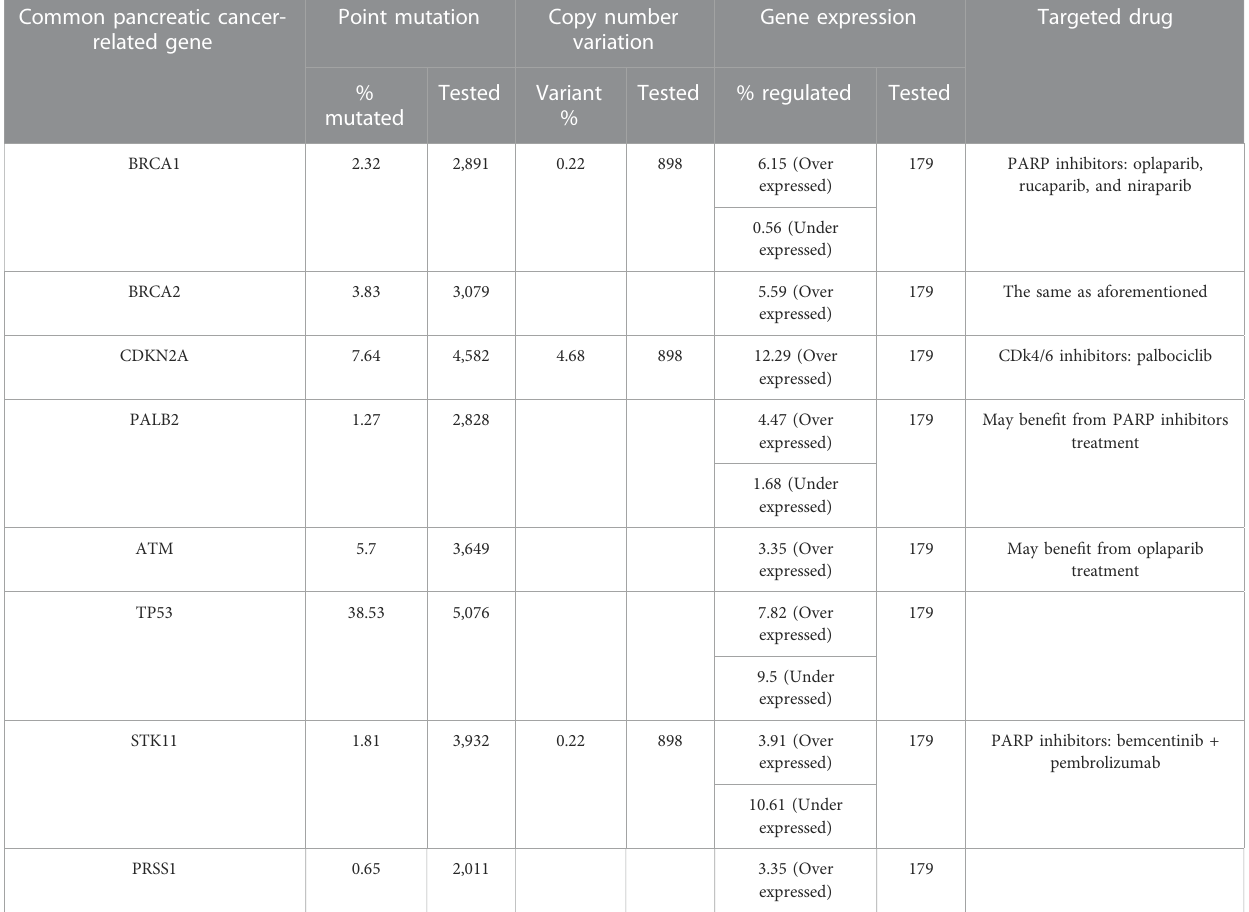
TABLE 1 Common pancreatic cancer-related gene variations and possible effective targeted drugs (some table contents based on the public data of COSMIC). Common pancreatic cancer- related